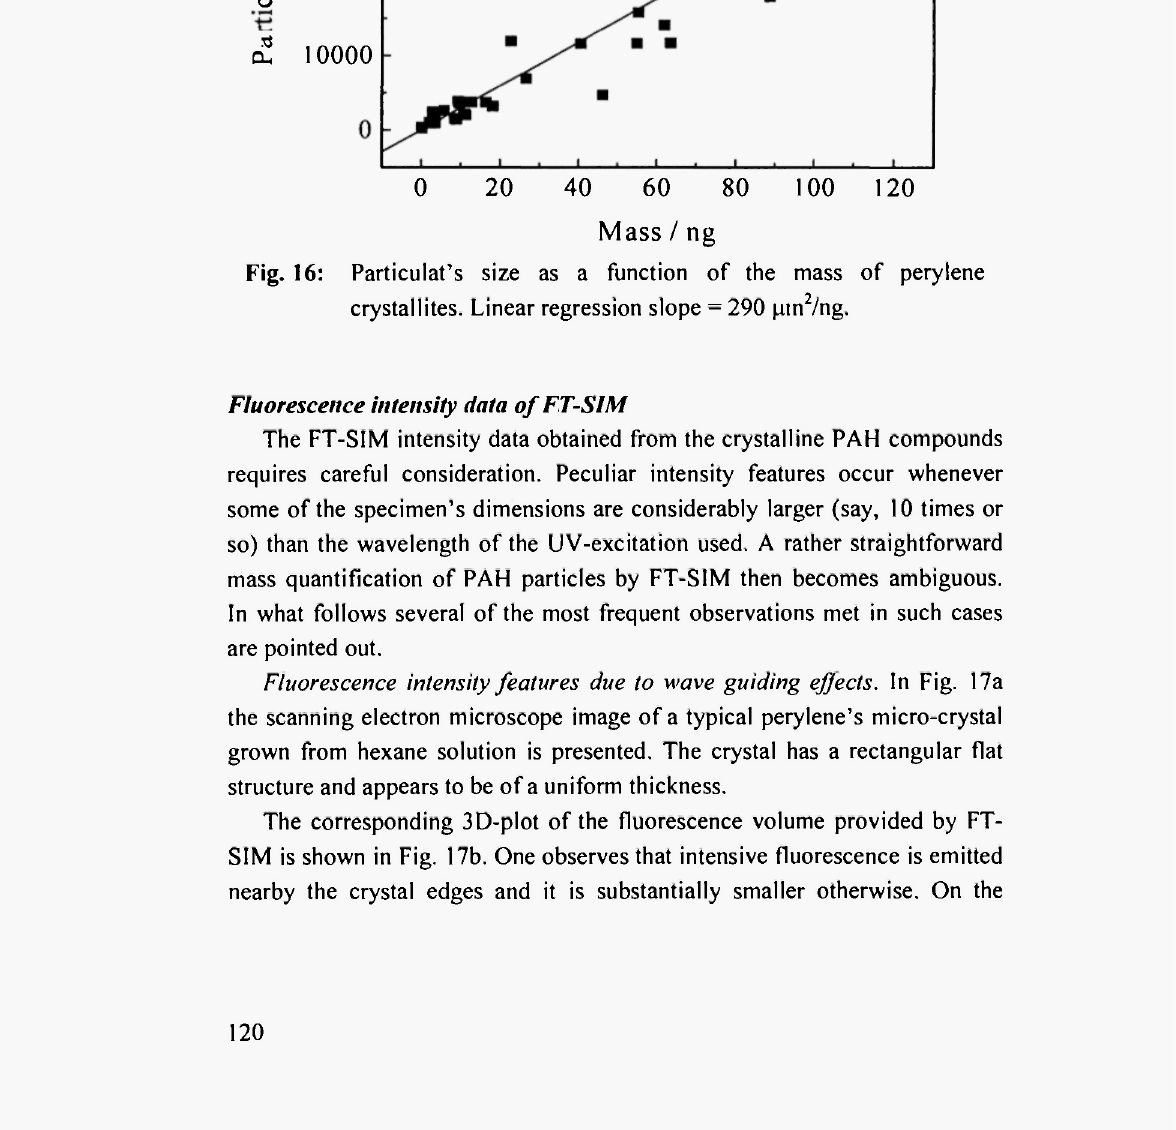
Fig. 16: Particulat's size as a function of the mass of perylene crystallites. Linear regression slope = 290 mn 2